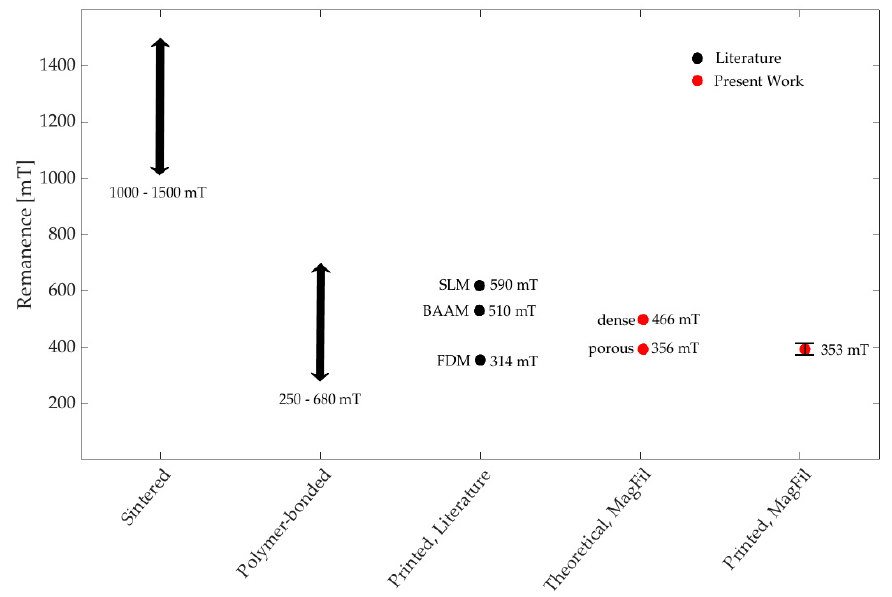
Figure 3. Comparison of remanences of NdFeB magnets in the form of commercially available sintered magnets [21], polymer-bonded magnets [22], magnets printed by selective laser melting (SLM) [6], big area additive manufacturing (BAAM) [2], and fused deposition modelling (FDM) [5] (Printed, Literature), theoretical remanences of the developed polymer-bonded magnetic compound as dense material and according for a porosity of 24% (Theoretical, MagFil) and the measured remanence of printed MagFil cylinders (Printed, MagFil; SD = 7%).